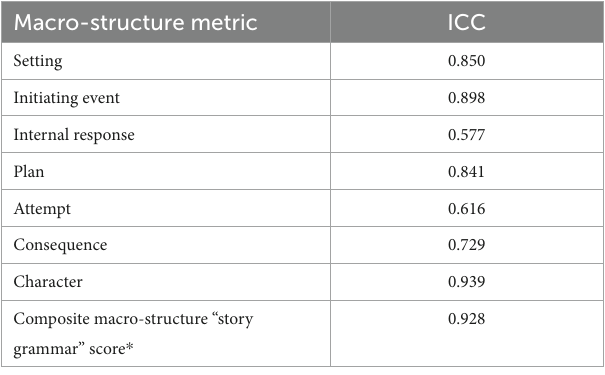
TABLE 5 Macro-structure metrics ICC scores for monolingual replacement samples ( n =